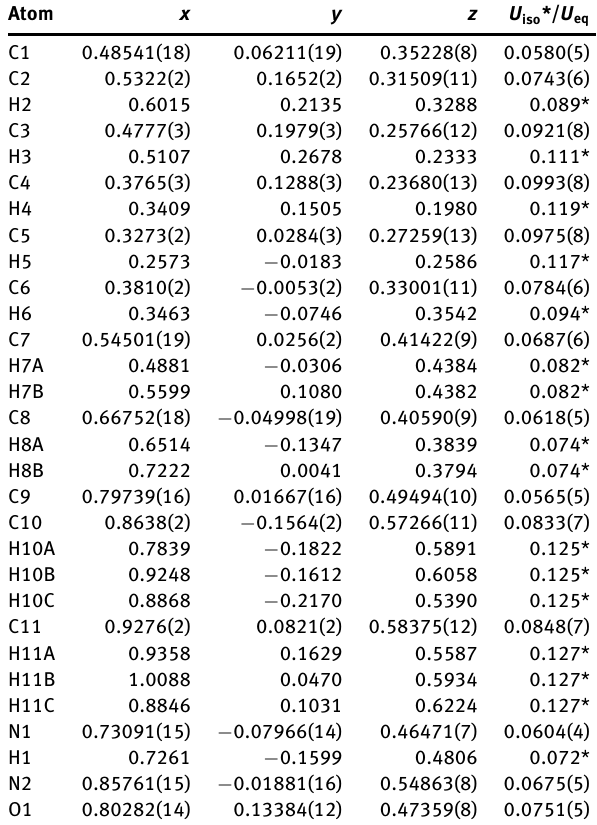
Table 2: Fractional atomic coordinates and isotropic or equivalent isotropic displacement parameters (Å 2